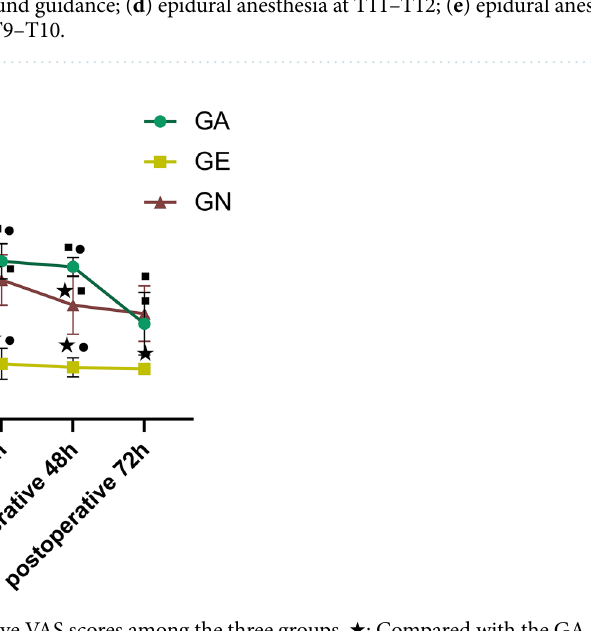
Figure 5. Comparison of postoperative VAS scores among the three groups. ★ : Compared with the GA